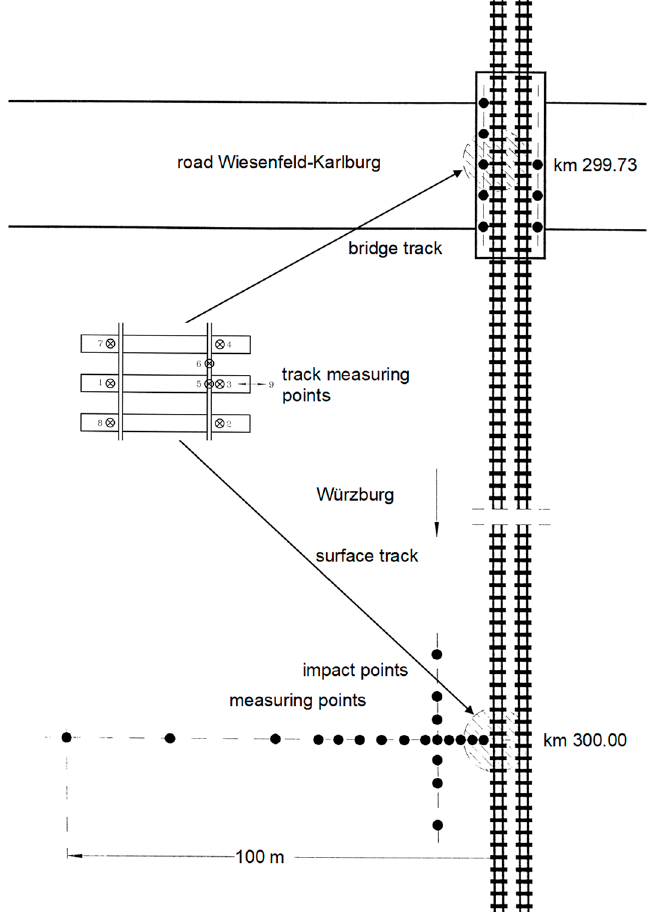
Figure 2. Layout of the measurements at the surface line and the bridge with track, bridge, and soil measurement points.